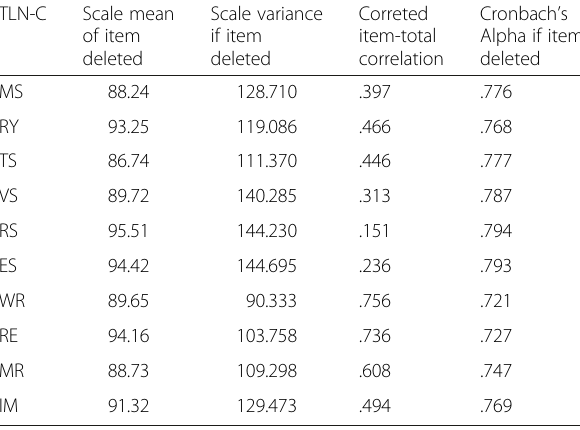
Table 6 Internal consistency reliability (Alfa de